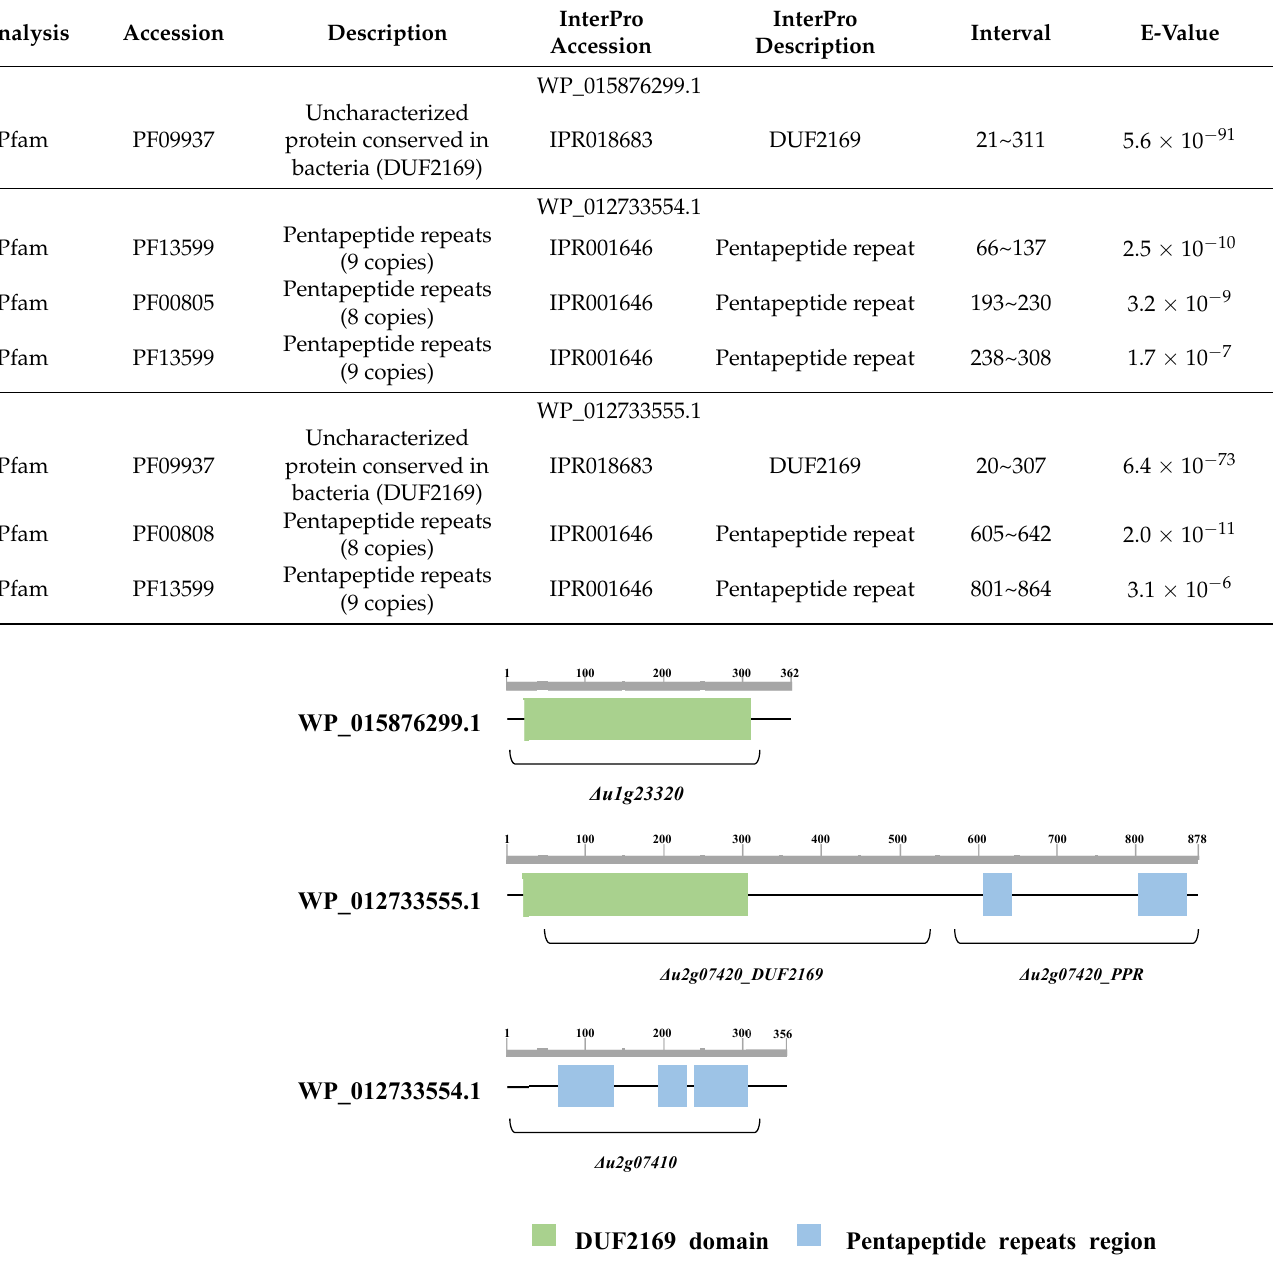
Table 1. Functional analysis of WP_015876299.1, WP_012733554.1, and WP_012733555.1 from the InterPro database.